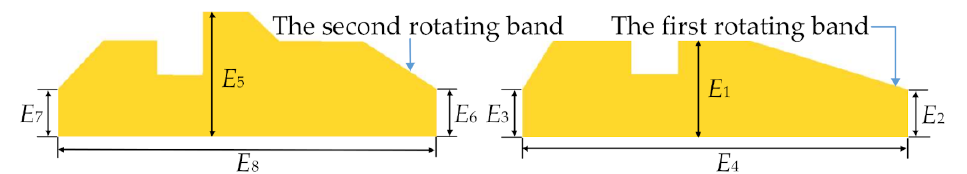
Figure 17. Schematic diagram of the position of size parameters on the cross profile of the rotating bands.